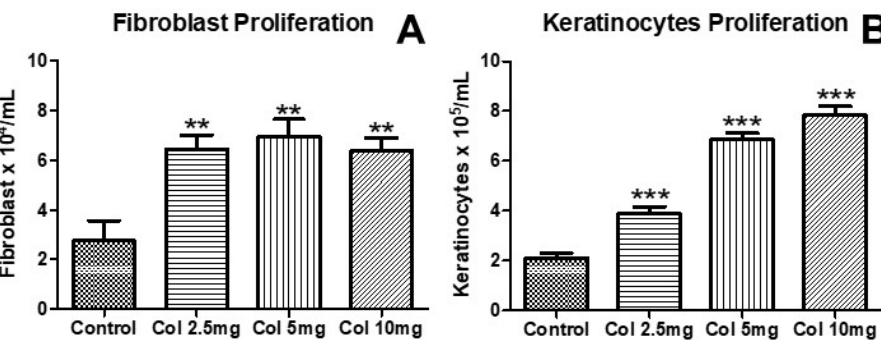
Figure 1. The effects of collagen supplementation on human fibroblast ( A ) and human keratinocyte ( B ) proliferation. For ( A ), ** p < 0.01 compared with the control group. For ( B ), *** p < 0.001 compared with the control group. Col, collagen.